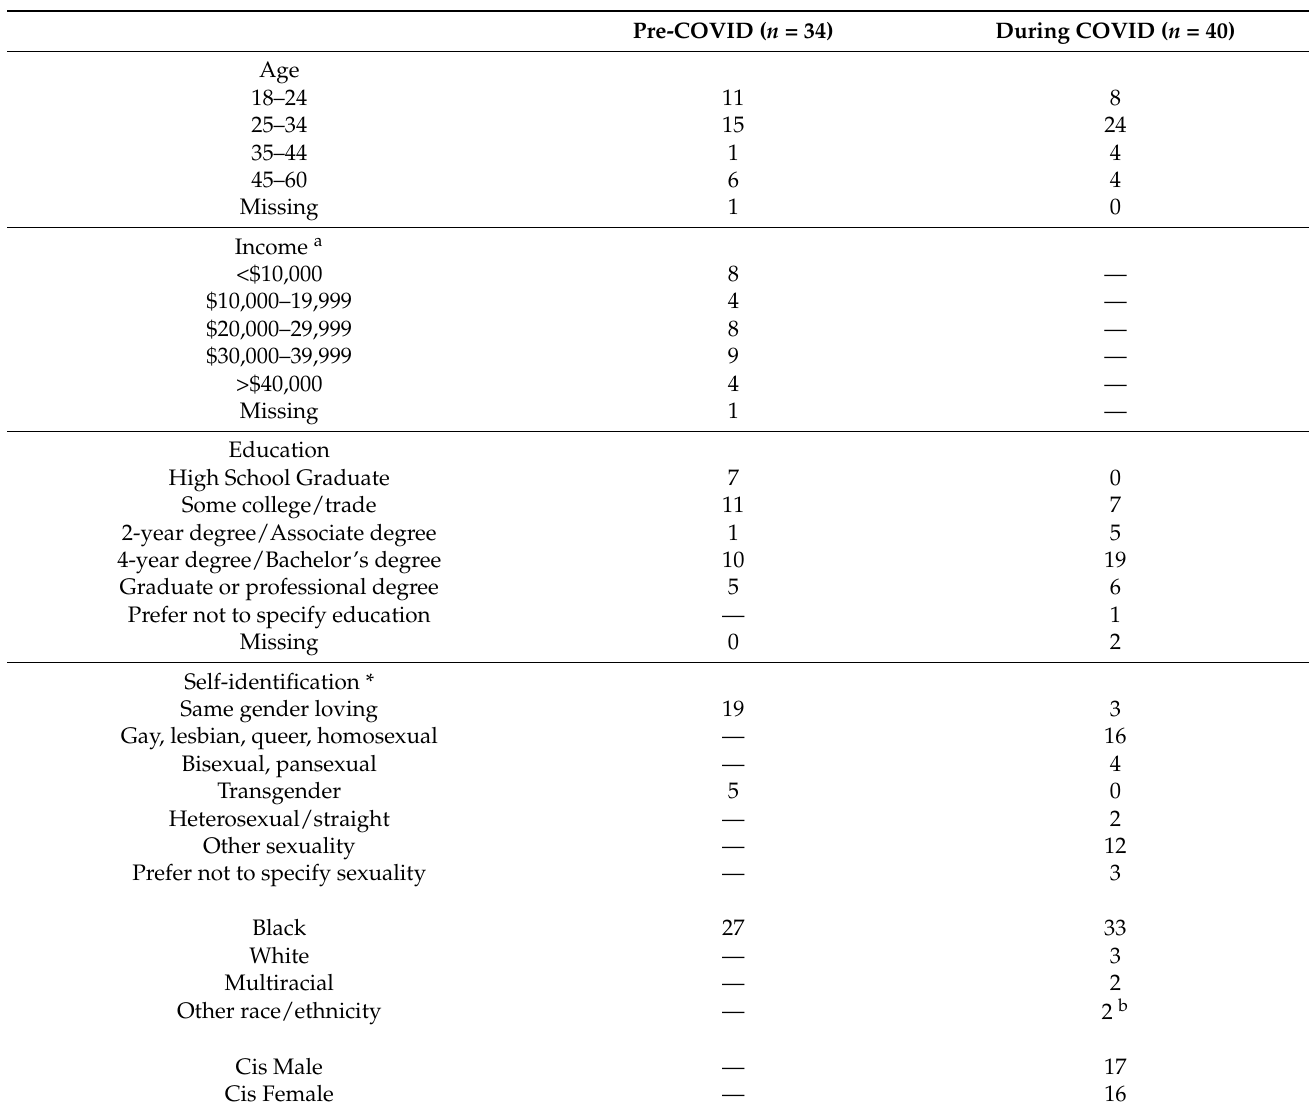
Table A2. Participant characteristics for Whole YOUniversity 1.0 (pre-COVID) vs. 2.0 (during